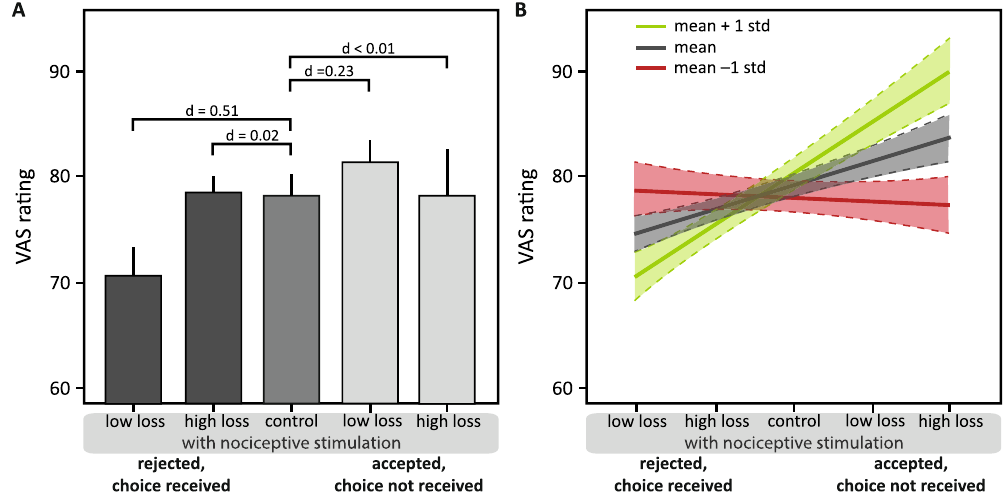
Figure 4. Perception of the nociceptive stimulation in lose trials. ( A ) Means and 95% confidence intervals of VAS ratings in the five conditions with nociceptive stimulation: rejected and received with low loss, rejected and received with high loss, control condition, accepted and not received with low loss, accepted and not received with high loss. Post-hoc comparisons: effect size indicated by Cohen’s d. ( B ) Effects of subjective utility as a moderator are depicted by regression lines with 95% confidence intervals of estimated VAS ratings at below average (mean − 1 standard deviation; green), average (mean; grey), and above average (mean + 1 standard deviation; red) values of the utility index. The higher the values of the utility index, the higher the participant’s tendency to accept a win and nociceptive stimulus and the stronger the perceptual